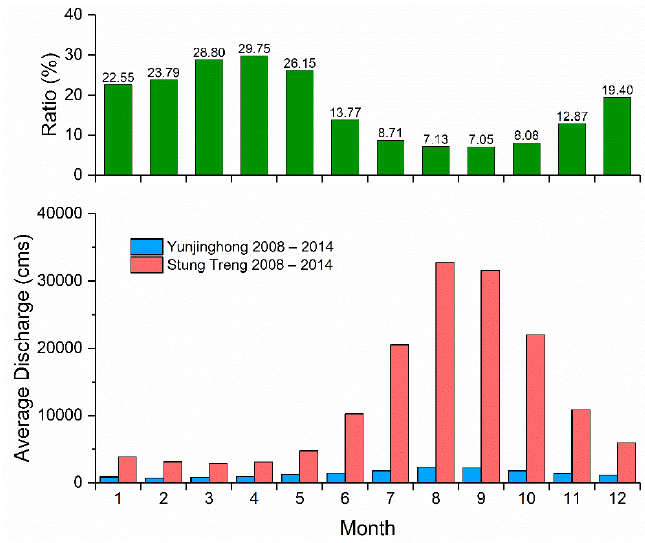
Figure 11. Variation in Runoff during the Flood and Dry Seasons Measured at the Yunjinghong Hydrological Station before and after 2008.